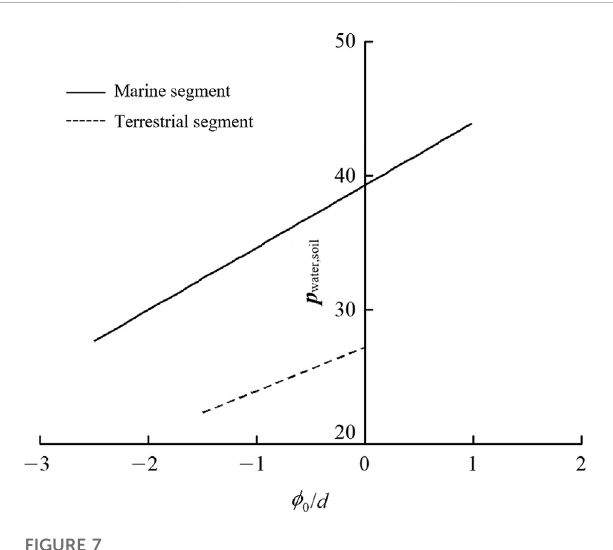
FIGURE 7 In fl uence of drainage conditions.